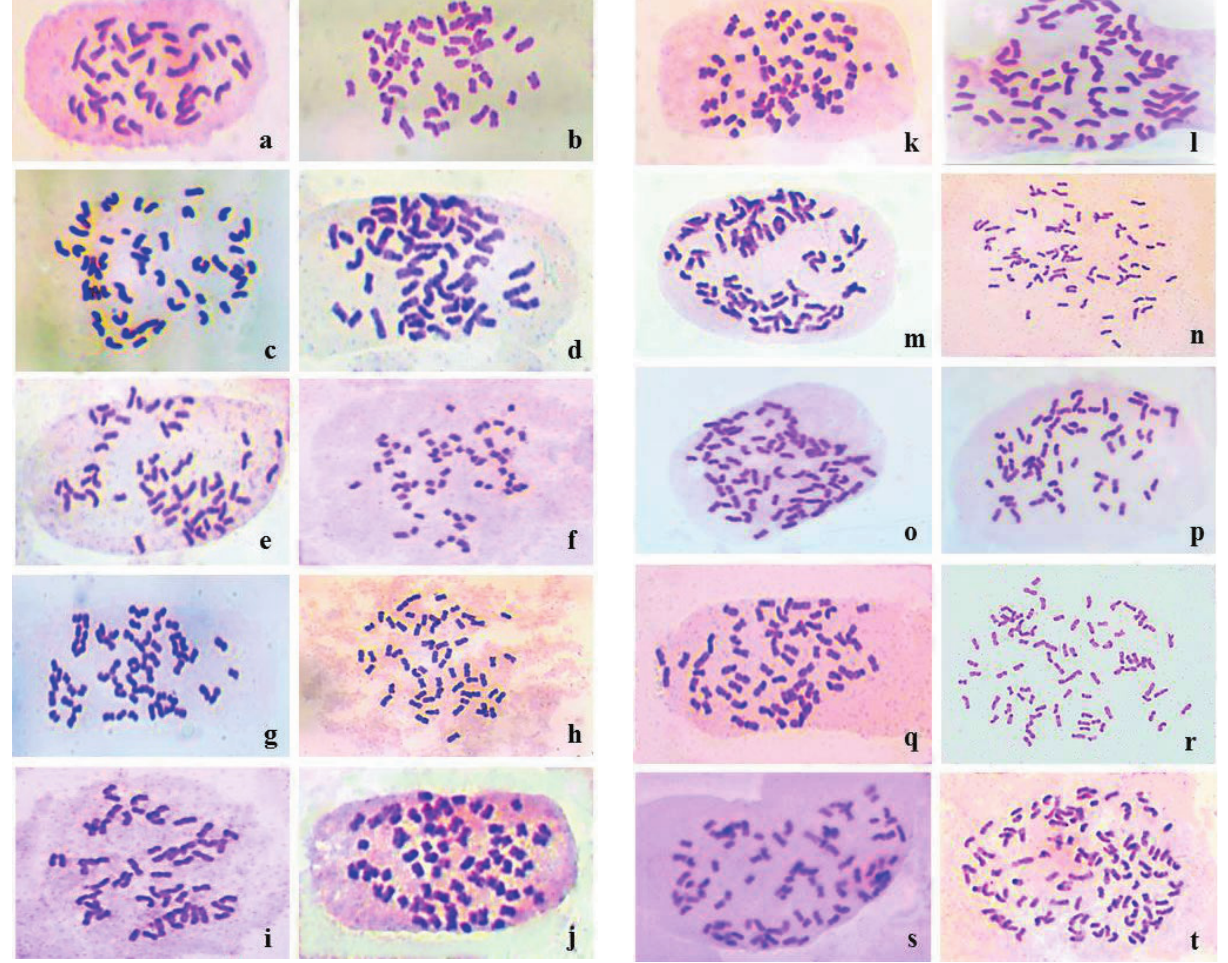
Figure 1. (a) – (t) Somatic chromosomes in different cytotypes of S. spontaneum a) IND 16-1812 (2n=40), b) IND 16-1792 (2n=48), c) IND 11-1606 (2n=54), d) IND 11-1604 (2n=56), e) IND 11-1614 (2n=58), f) IND 10-1574 (2n=60), g) IND 89-754 (2n=62), h) IND